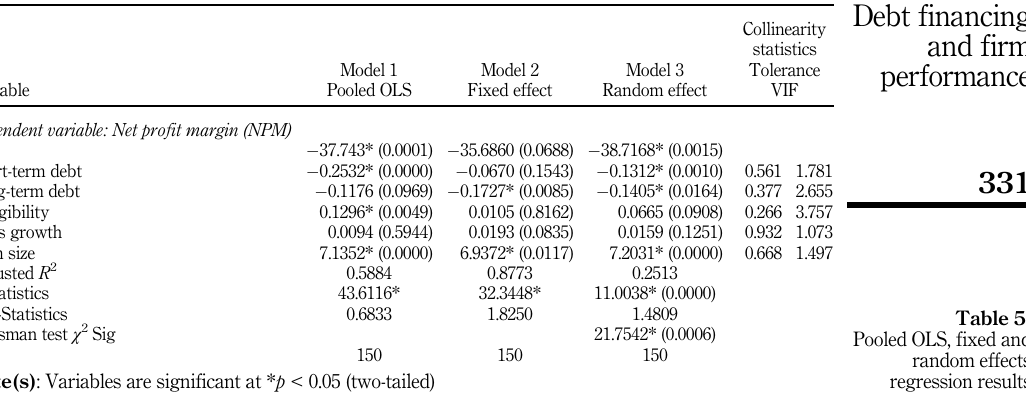
Table 5. Pooled OLS, fixed